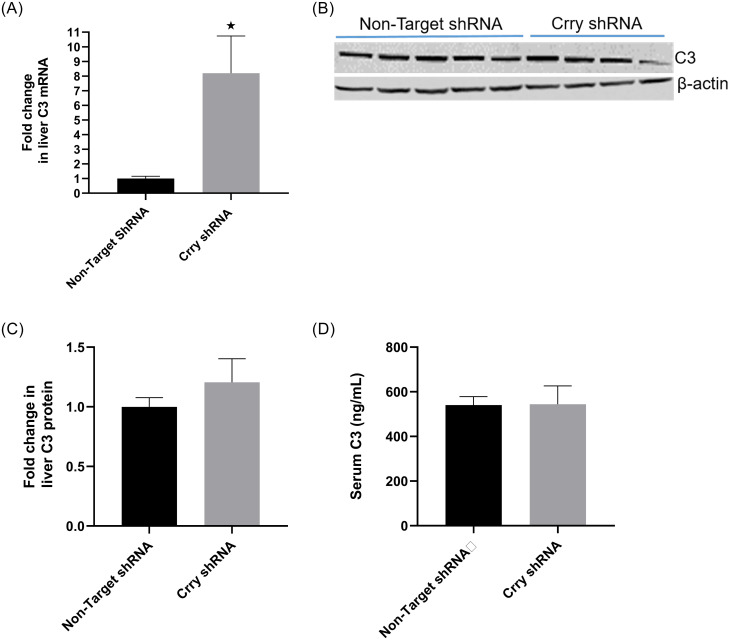
Feed-back upregulation of C3 in liver.Liver and serum C3 level on 17.5 dpc in pregnant mice (n = 5–7) were measured. A) RT-qPCR showing significantly (p = 0.012) elevated C3 transcript levels in liver from CrryshRNA mice compared to control mice. B) Representative Western blot showing C3 expression level in liver C) Density analysis of liver C3 Western bands reveled no difference in its levels between CrryshRNA and control groups D) Serum C3 levels measured by ELISA showing no difference between CrryshRNA and control mice.